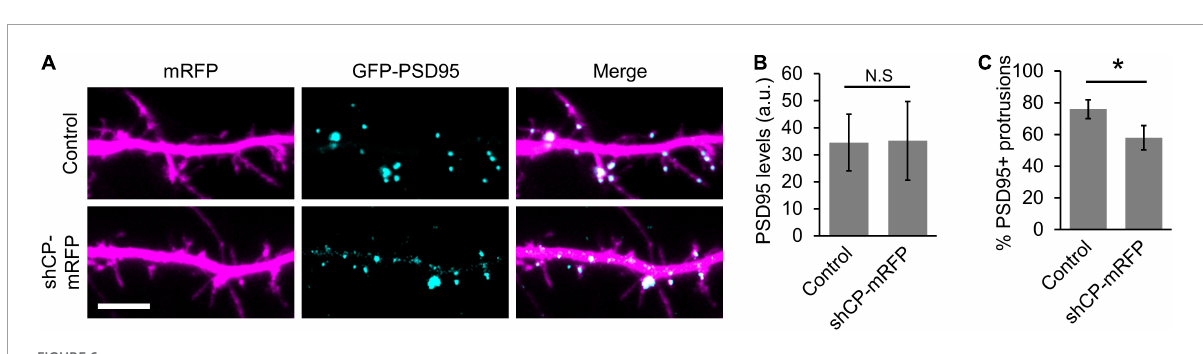
FIGURE6 Capping protein (CP) knockdown negatively affects PSD95 clustering in spines. (A) Representative dendritic regions showing that CP knockdown decreases the number of protrusions containing GFP-PSD95. (B) Quantification shows no significant difference in the levels of GFP-PSD95 between control and shCP-mRFP cells. (C) Quantification shows significant reduction in the percentage of dendritic protrusions containing GFP-PSD95 puncta. N = 19 cells per condition. Scale bar, 5 µ m. Error bars represent SEM. * P < 0.001; Mann–Whitney